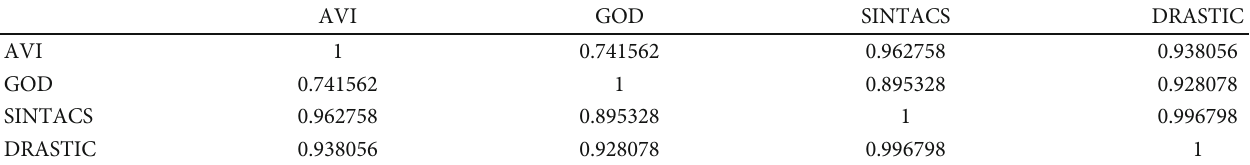
Table 14: Correlation matrix between the maps computed using AVI, GOD, SINTACS, and DRASTIC. AVI AVI